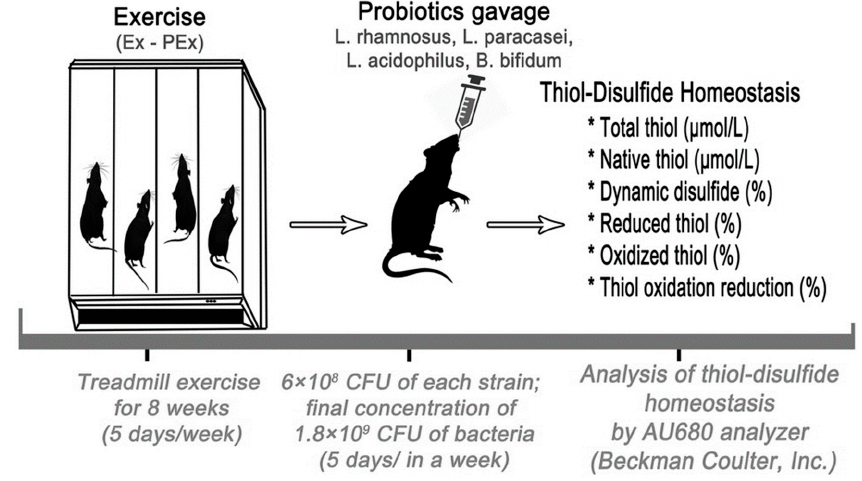
Figure 1. Experimental protocol of the study.